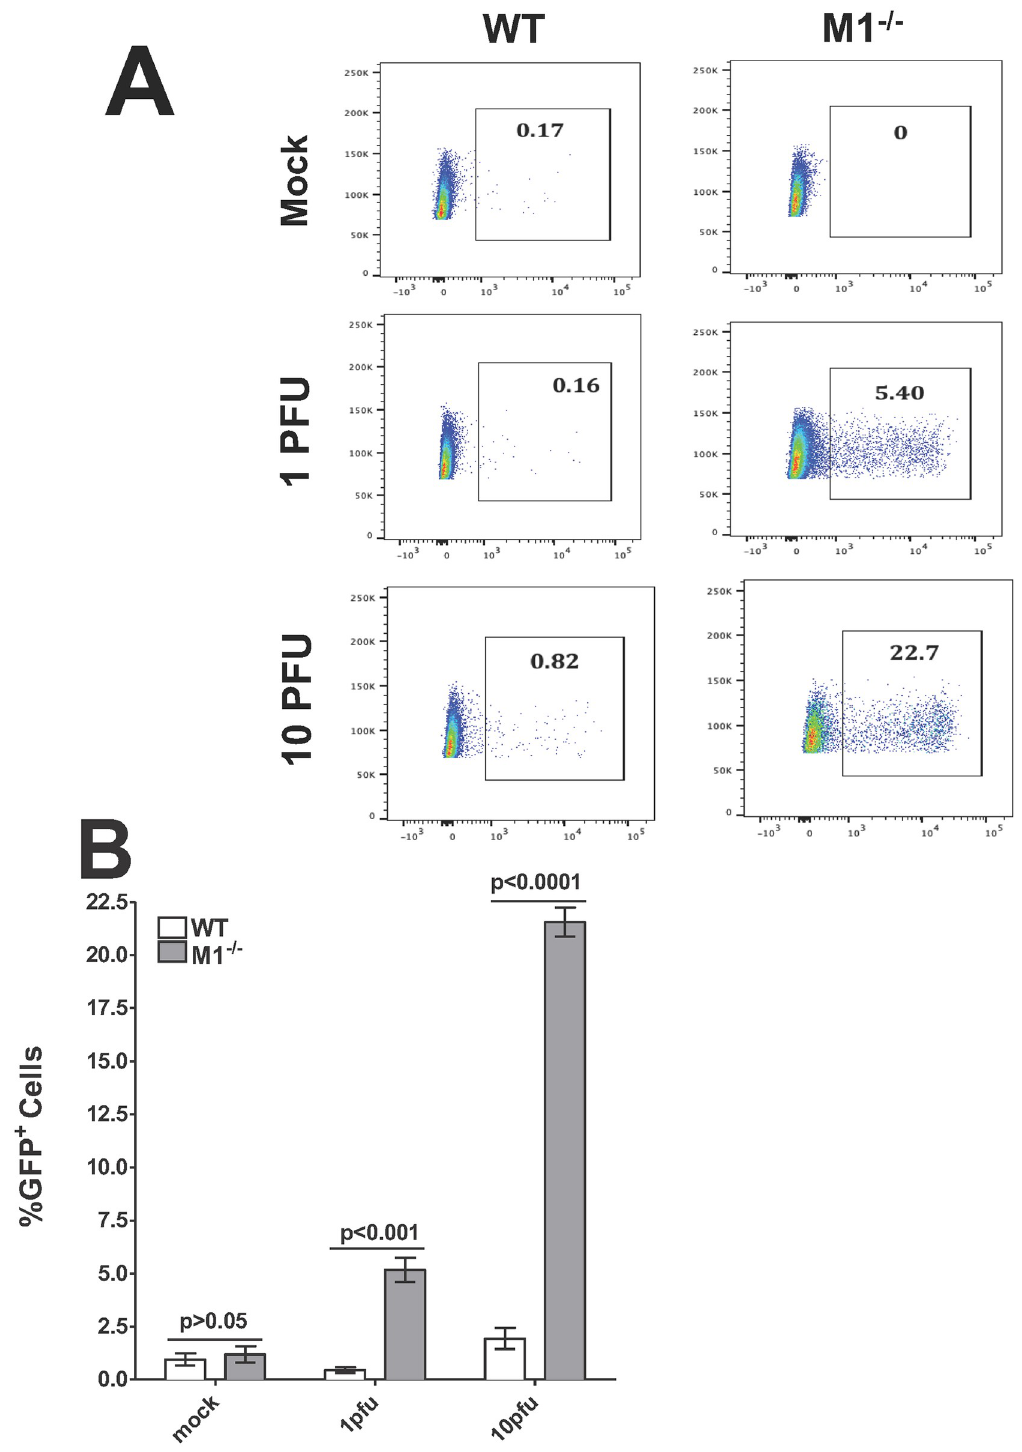
Fig 3. FACS analyses of isolated macrophages. Subconfluent monolayers of macrophages isolated from M1 -/- and WT mice were infected with 1 or 10 pfu/cell of HSV-GFP + virus. At 24 hr PI, cells were harvested for FACS analysis. The percent of cells positive for GFP-expression are shown. Panels: A) Representative plots of HSV-GFP + infected with 1 or 10 pfu/cell or mock- infected macrophages; and B) Percentage plots of HSV-GFP + infected or mock-infected macrophages and quantified by FACS. Each point represents the mean ± SEM from two independent experiments (N = 4).